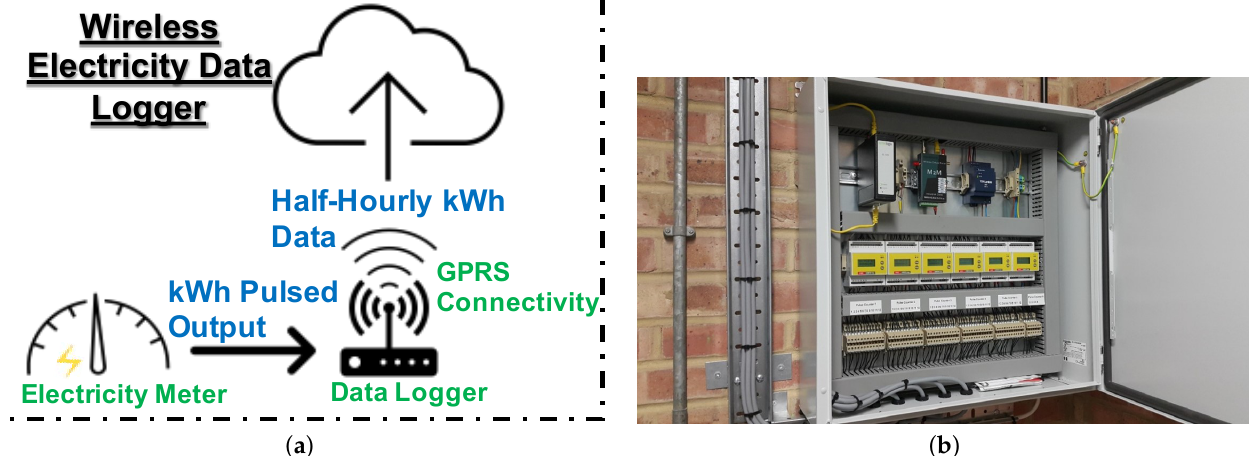
Figure 10. Smart electricity monitoring system installed in Medway NHS hospital. ( a ) Block diagram and data flow. ( b ) System